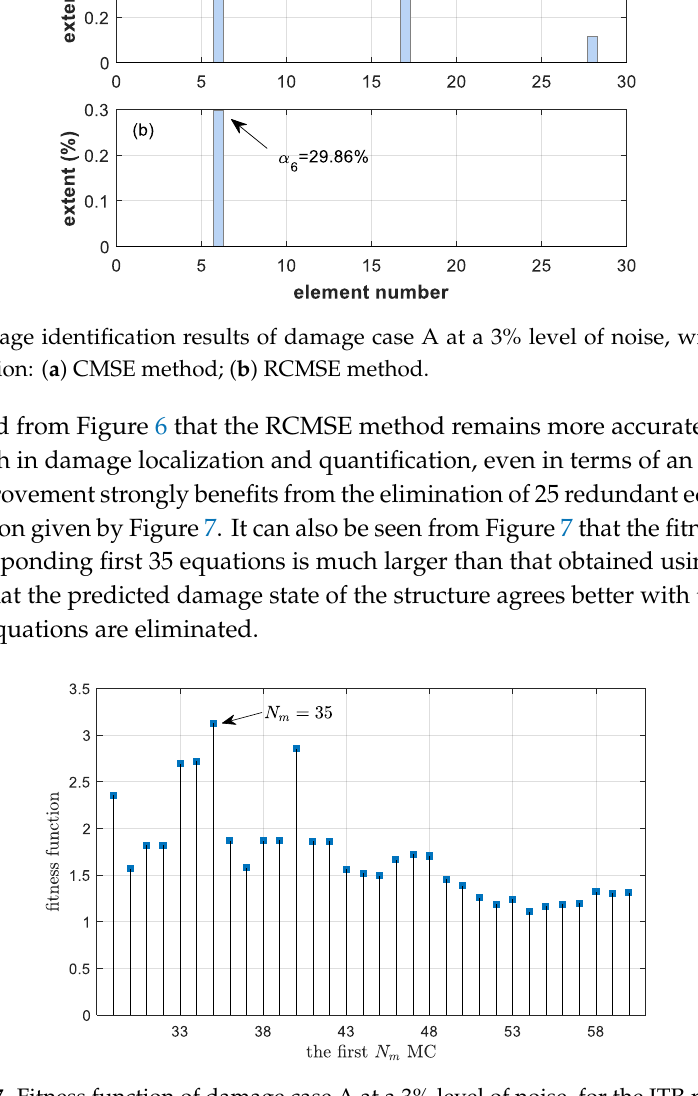
Figure 8. Damage identification results of damage case B at a 3% level of noise, with an iterative Tikhonov solution: ( a ) CMSE method; ( b ) RCMSE method. It should be noted that in this case only 40 equations are used to predict the preset damage location and extent of damage (see Figures 9 and 10), confirming that not all equations contribute to damage detection but complicate the CMSE system. Furthermore, by performing the analysis of CMSE equations’ sensitivity to damage, numerous redundant equations are eliminated, thereby simplifying the CMSE system. Figure 9. Sensitivity index of damage case B versus MCs 𝑁 𝑖 = 20 and 𝑁 𝑗 = 3 , at a 3% level of noise.